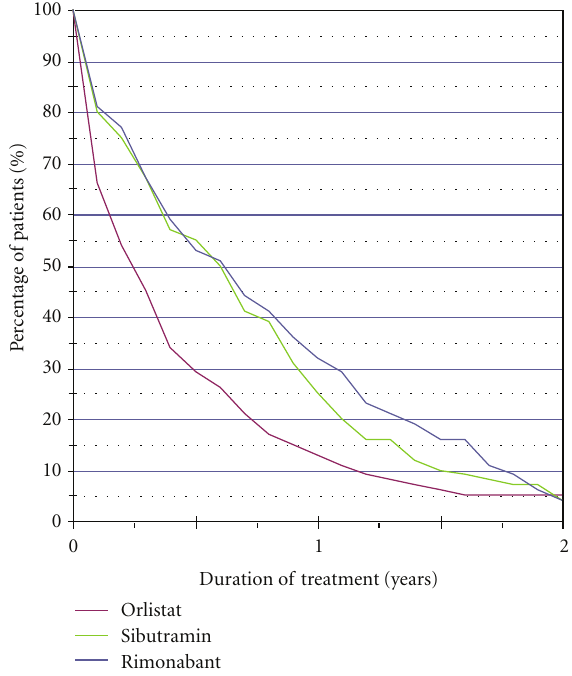
Figure 2: Percentage of patients left on treatment.